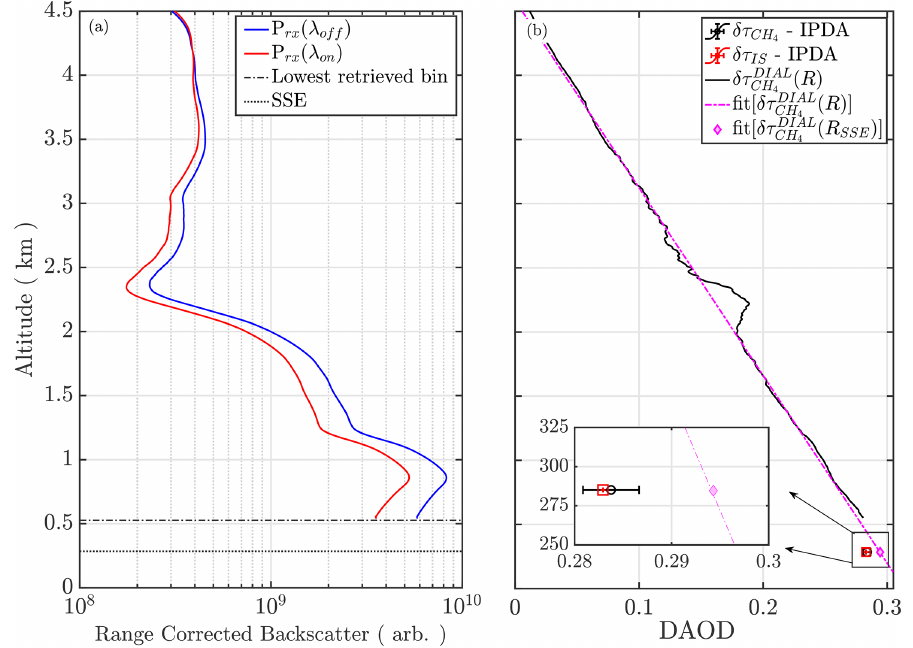
Figure 17. (a) The 1645nm range-corrected online and offline over the overpass region averaged to 350m vertical by 12.5km along-track resolution. (b) The range-resolved DAOD as the black line, with fitted DAOD from the range-resolved profile shown by the magenta dashed line. The magenta “diamond” emphasizes the fitted value at the SSE, the IPDA-derived DAOD is the black circle with 1 σ error bars, and in situ-derived DAOD is the red box.